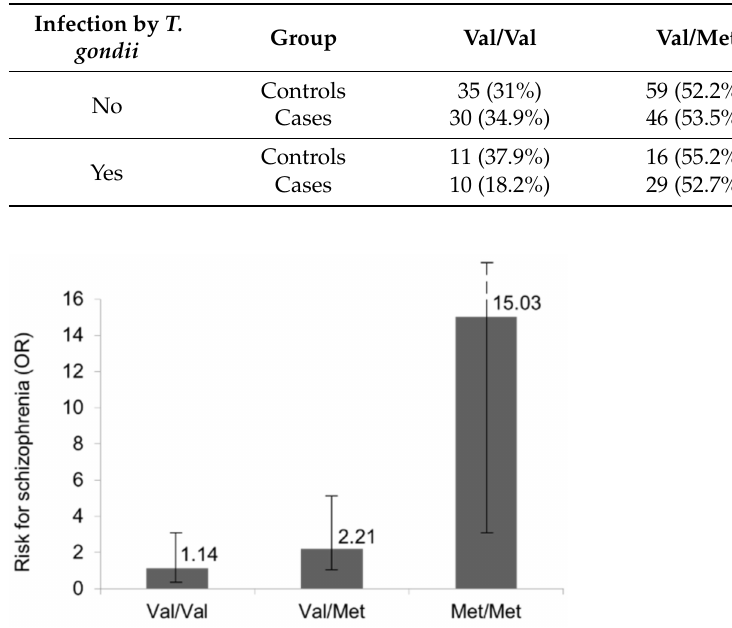
Table 4. Stratified analysis of levels of exposure for both COMT genotypes and T. gondii infection among cases and controls.